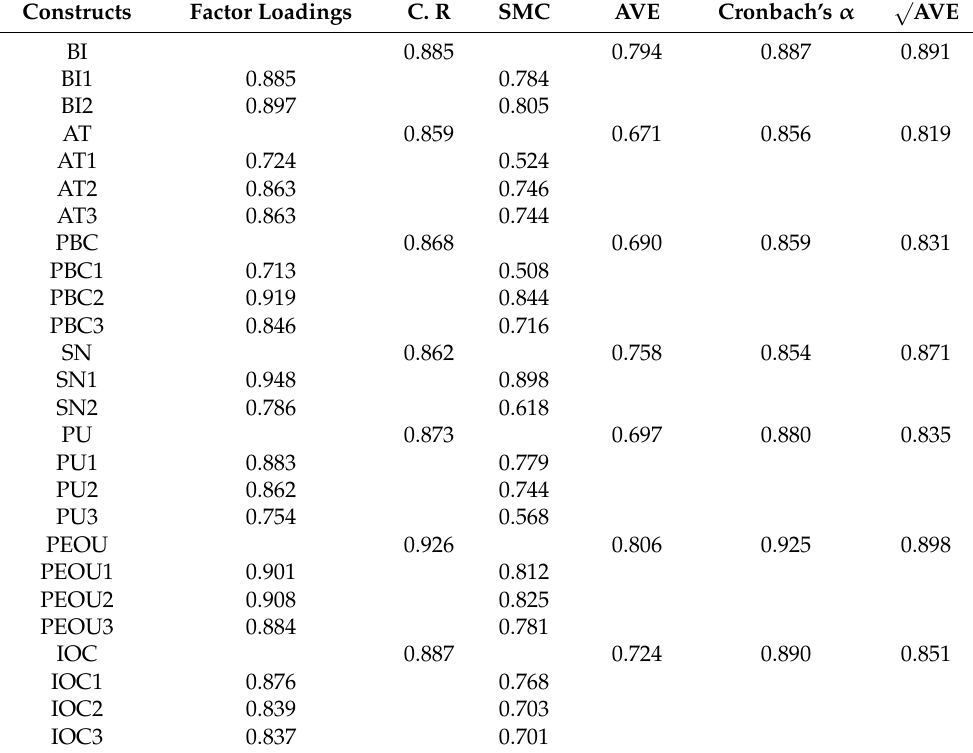
Table 5. Measurement model: reliability and validity.